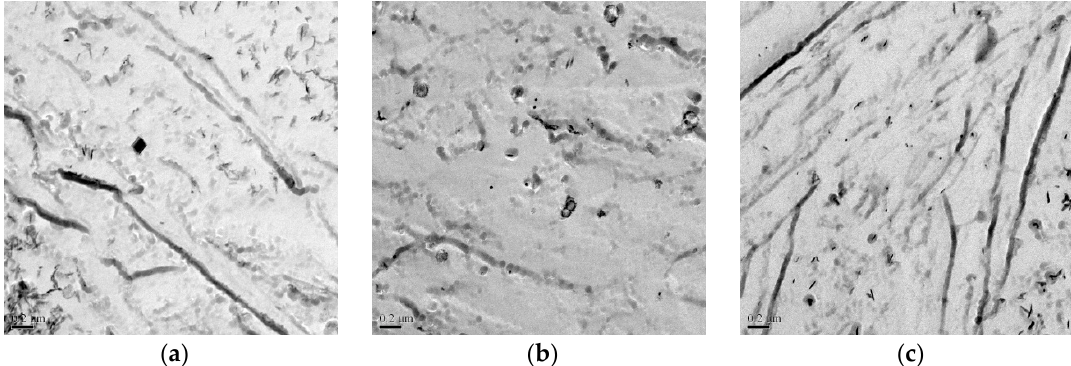
Figure 8. Typical TEM micrographs of extraction carbon replicas in SSC process ( a ): cooling to 600 °C and holding for 2 min; ( b ): reheating to 1000 °C; ( c ): cooling to 800 °C at a cooling rate of 1 °C/s.